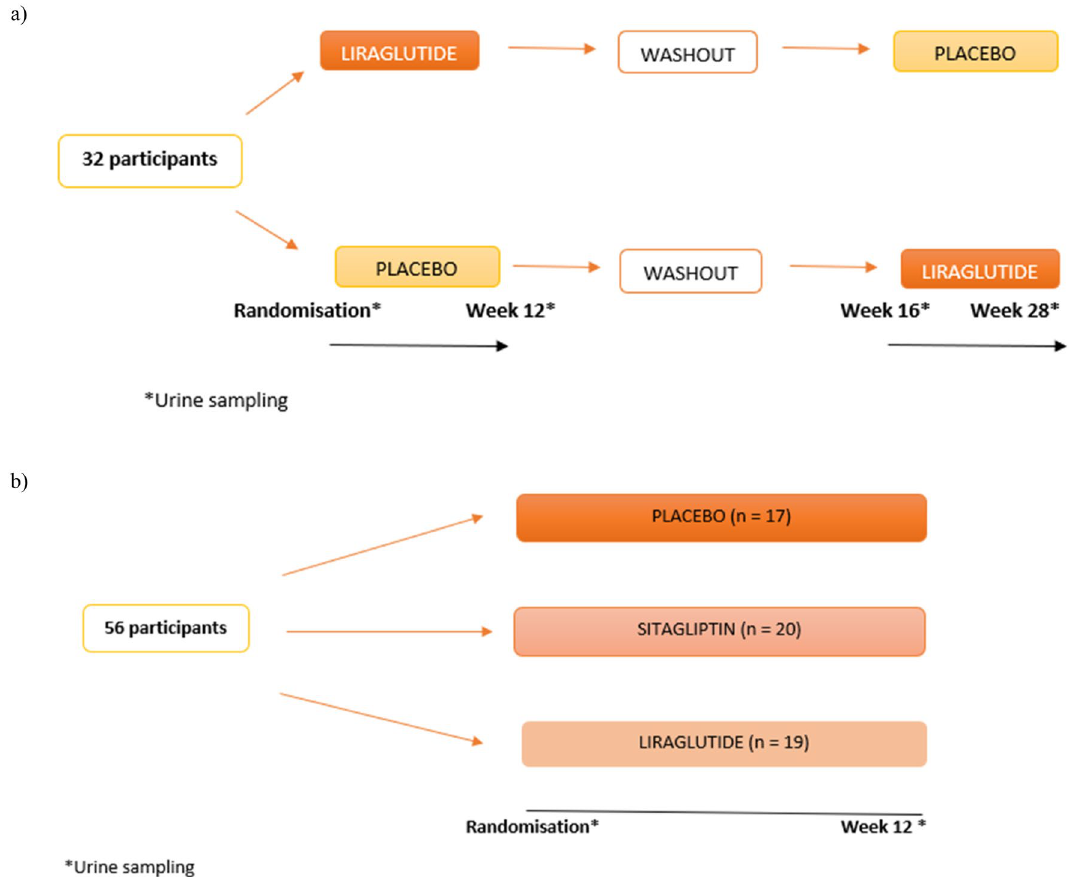
Figure 1. (a) Study design: The LIRALBU study. (b) Study design: The SAFEGUARD